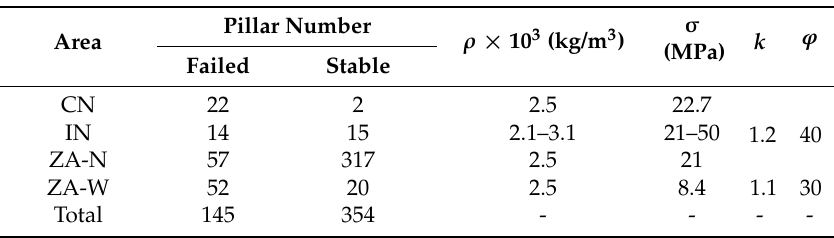
Table 2. The parameters used in pillar stability